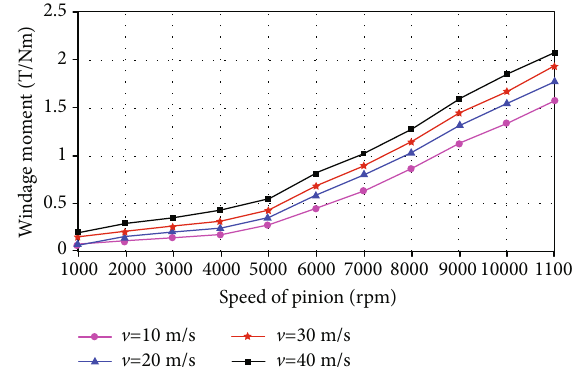
Figure 14: Windage torque of gear pair with pinion speed under di ff erent oil jet